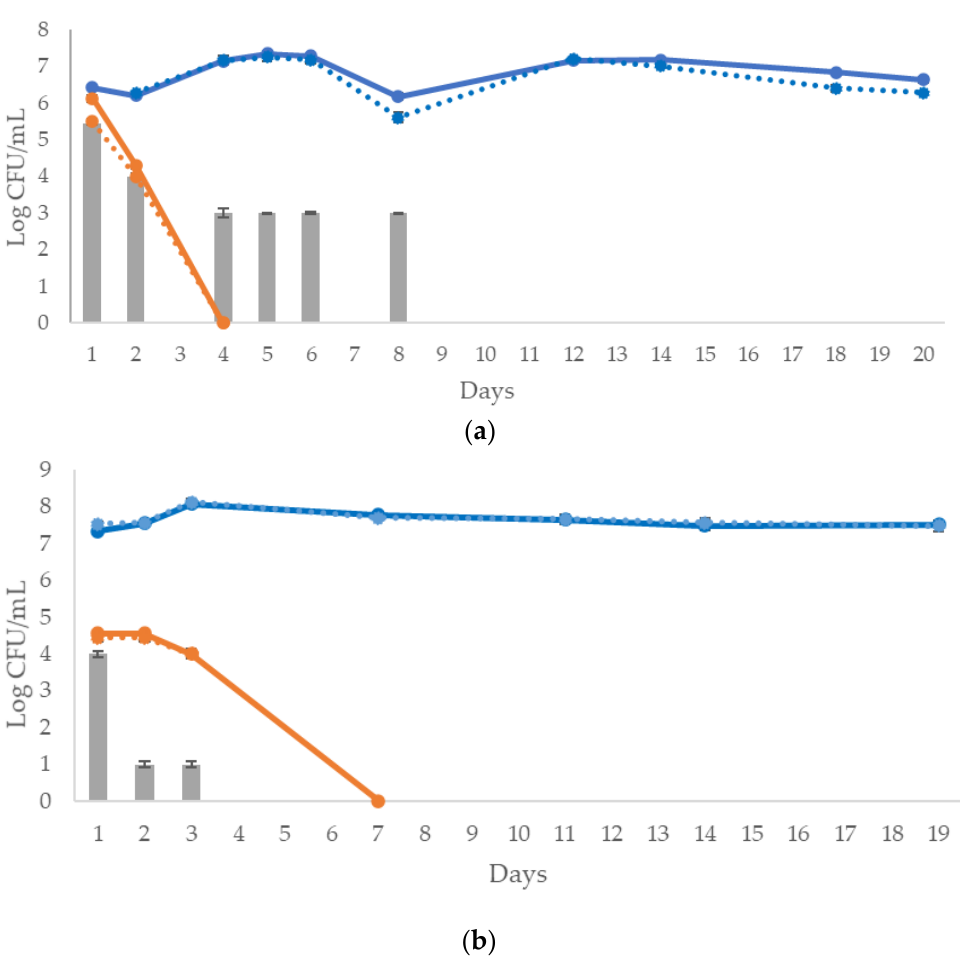
Figure 2. Growth kinetics of the yeasts population in both ( a ) 2021 vintage and ( b ) 2022 vintage wines.